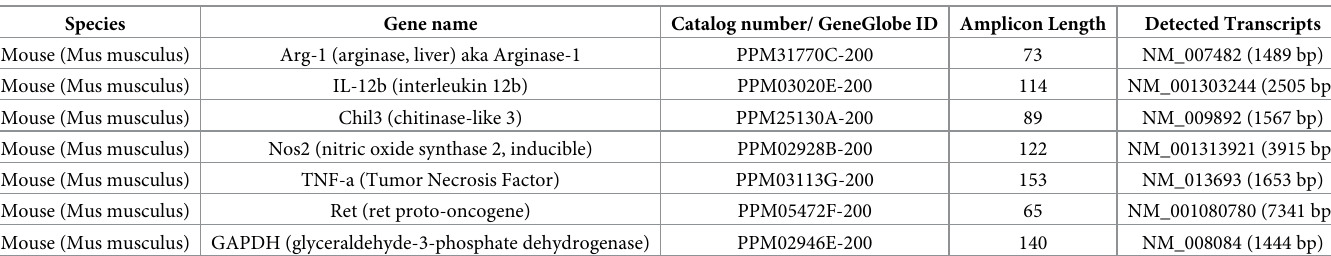
Table 1. qPCR primer